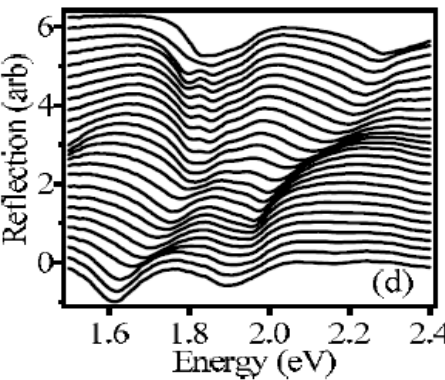
Figure 10. Normal incidence reflectivity vs. void thickness for a 20 nm J-aggregate film [75].